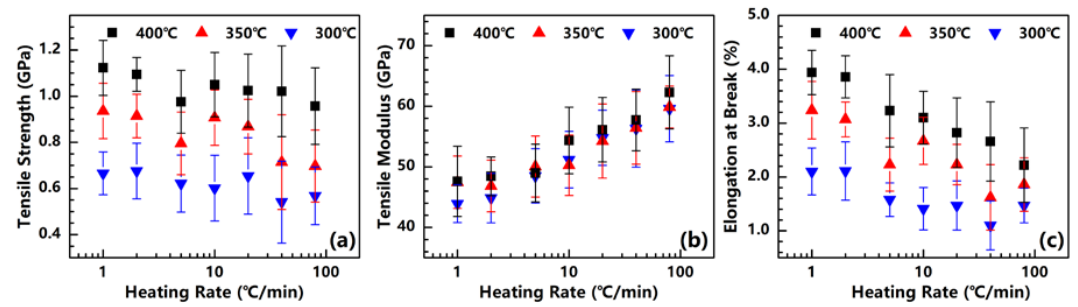
Figure 8. Tensile strength ( a ), Tensile modulus ( b ), and Elongation at break ( c ) of PI fibers obtained under different heating rates.